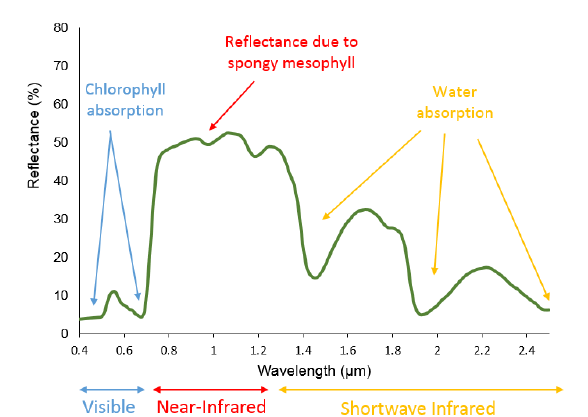
Figure 5. Spectral reflectance values (green vegetation)